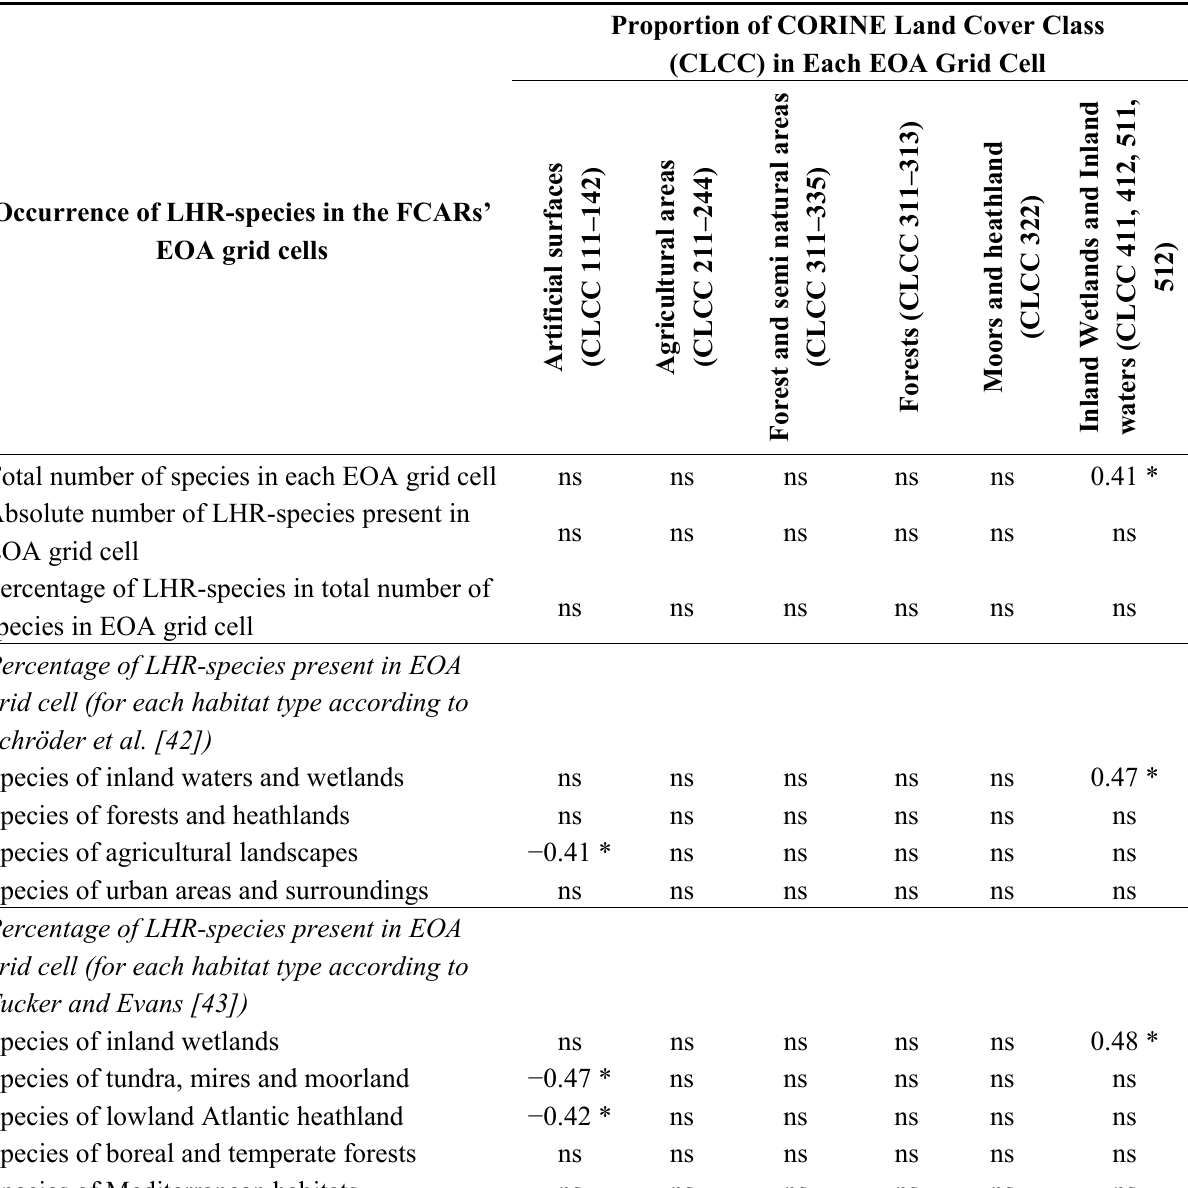
Table 8. Pairwise correlations (Spearman) between land cover and the occurrence of LHR-species in the FCARs’ EOA grid cells ( n =